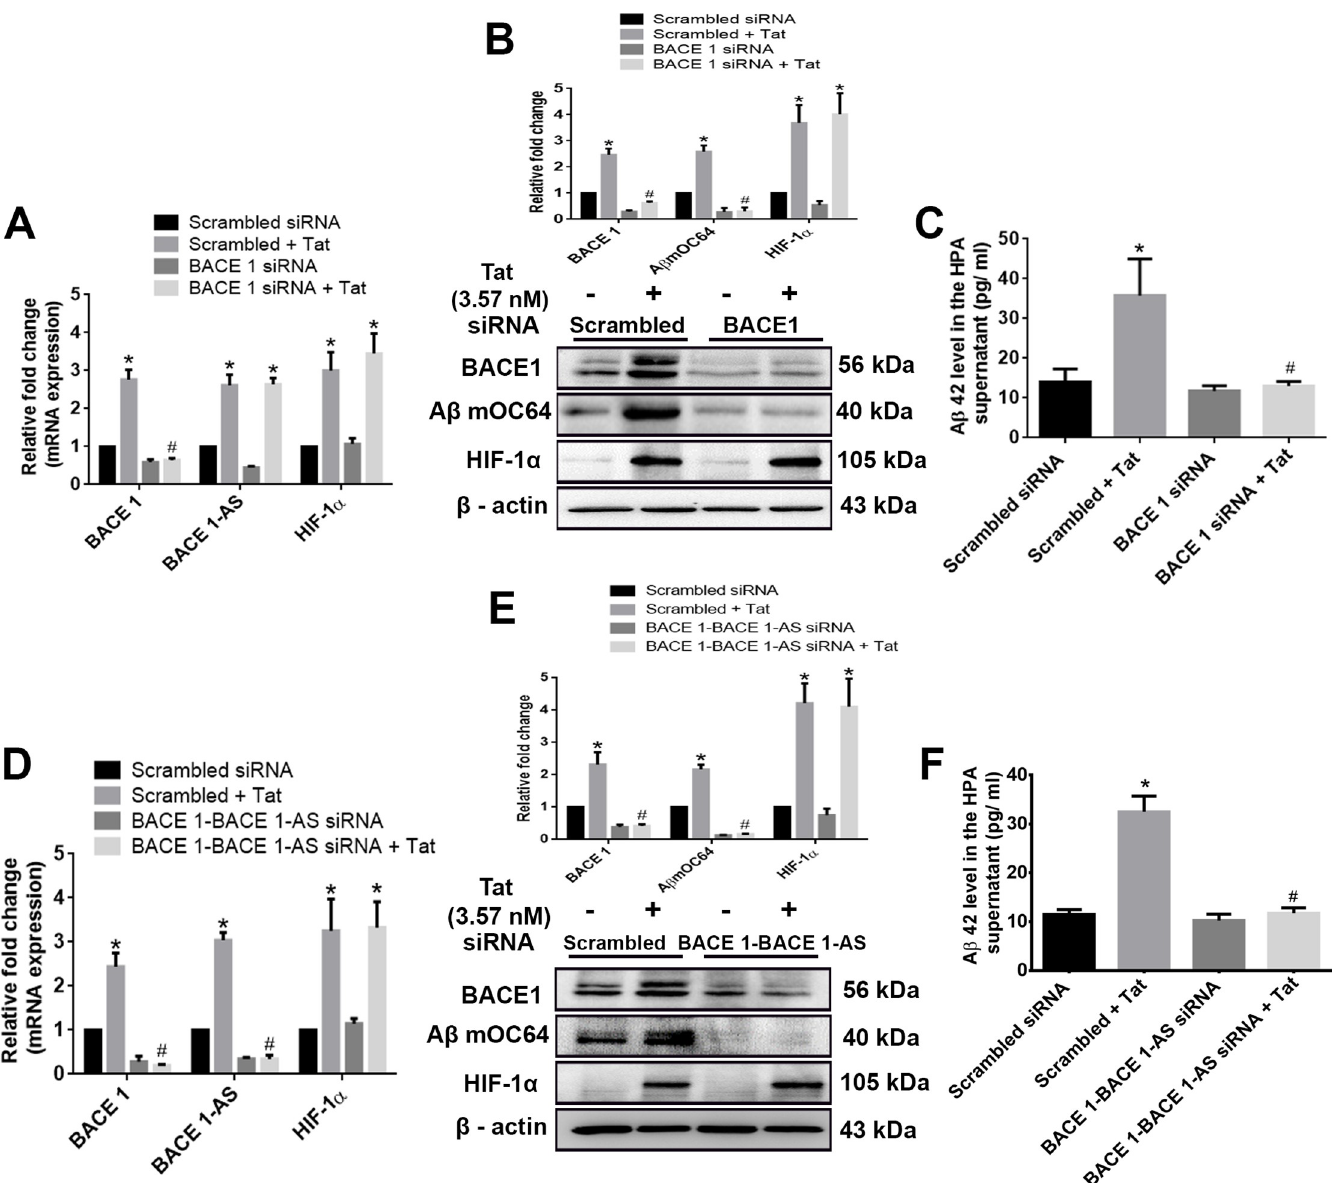
Fig 8. Role of BACE1 and/or BACE1-AS in HIV-1 Tat–mediated astrocytic amyloidosis. (A) qPCR showing expression of BACE1, BACE1-AS, and HIF-1 α RNA in HPAs transfected with either BACE1 or scrambled siRNA. (B) Representative western blots showing the expressions of BACE1, A β mOC64, and HIF-1 α in HPA transfected with either BACE1 or scrambled siRNA. (C) ELISA showing the protein levels of A β 42 in the supernatant of HPA transfected with either BACE1 or scrambled siRNA. (D) qPCR showing mRNA expressions of BACE1, BACE1-AS, and HIF-1 α in HPA transfected with either BACE1–BACE1-AS or scrambled siRNA. (E) Representative western blots showing the expressions of BACE1, A β mOC64, and HIF-1 α in HPA transfected with either BACE1–BACE1-AS or scrambled siRNA. (F) ELISA showing the protein levels of A β 42 in the supernatant of HPA transfected with either BACE1–BACE1-AS or scrambled siRNA. Data are presented as mean ± SEM; n = 6. One-way ANOVA followed by Bonferroni post hoc test was used to determine the statistical significance: � P < 0.05 versus control, # P < 0.05 versus Tat. The data underlying this figure may be found in S8 Data. A β , amyloid beta; BACE1, β -site cleaving enzyme; BACE1-AS, BACE1-antisense transcript; HIF-1 α , hypoxia-inducible factor; HPA, human primary astrocyte; qPCR, quantative polymerase chain reaction; siRNA, small interfering RNA; Tat, transactivator of transcription. https://doi.org/10.1371/journal.pbio.3000660.g008 of combined antiretroviral therapy in suppressing viremia, as the infected individuals continue to live longer, the prevalence of HAND and its association with comorbidities such as AD-like symptomatology are poised to be on the rise. The pathophysiology of observed deficits in